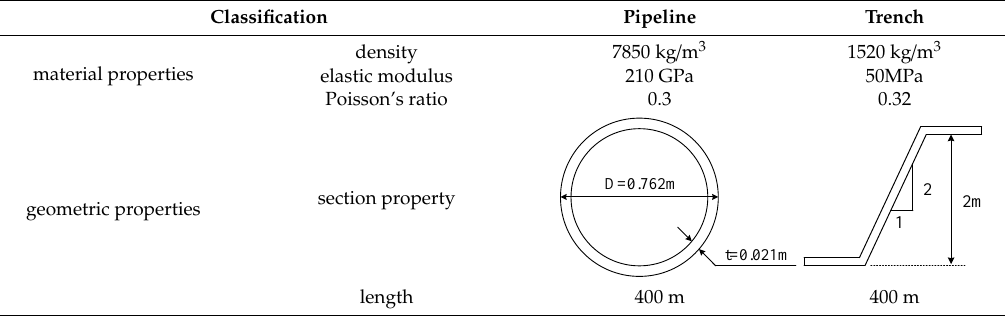
Table 1. Material and geometric properties for the finite element (FE) models.